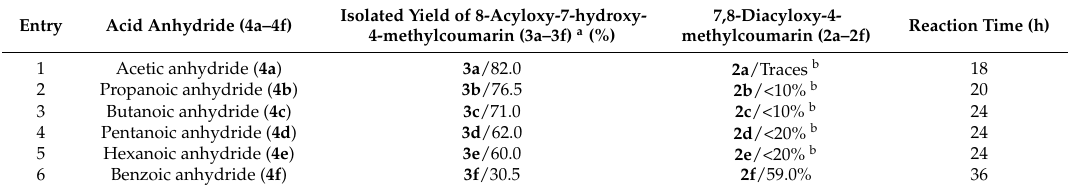
Table 1. Rhizopus oryzae lipase (ROL)-catalyzed regioselective formation of 8-acyloxy-7-hydroxy-4- methylcoumarins 3a – 3f in THF at 45 ◦